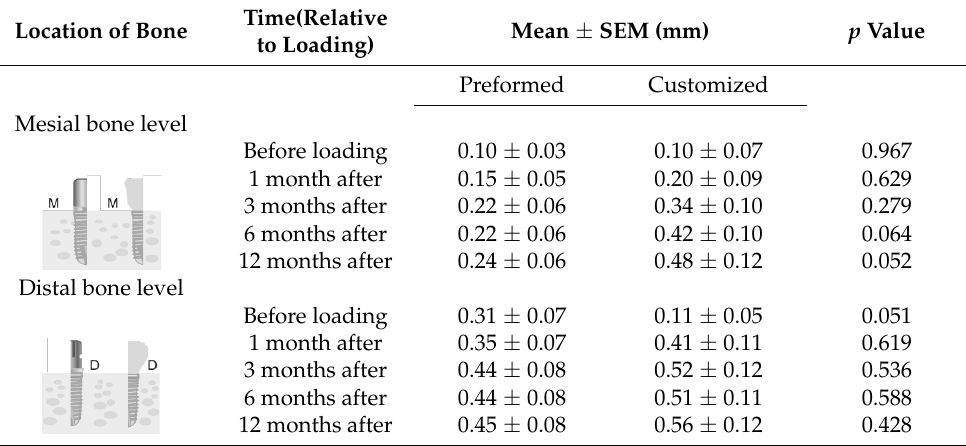
Table 4. Mesial and distal marginal bone levels between the PAs and CAs. CA, customized abutment; PA, preformed stock abutment; SEM, standard error of measurement.